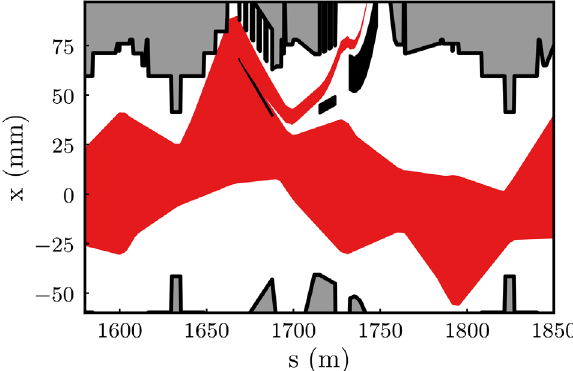
FIG. 4. Simulated beam envelope and machine aperture during slow extraction in the region of the SPS ring around LSS2 for a spiral step of 20